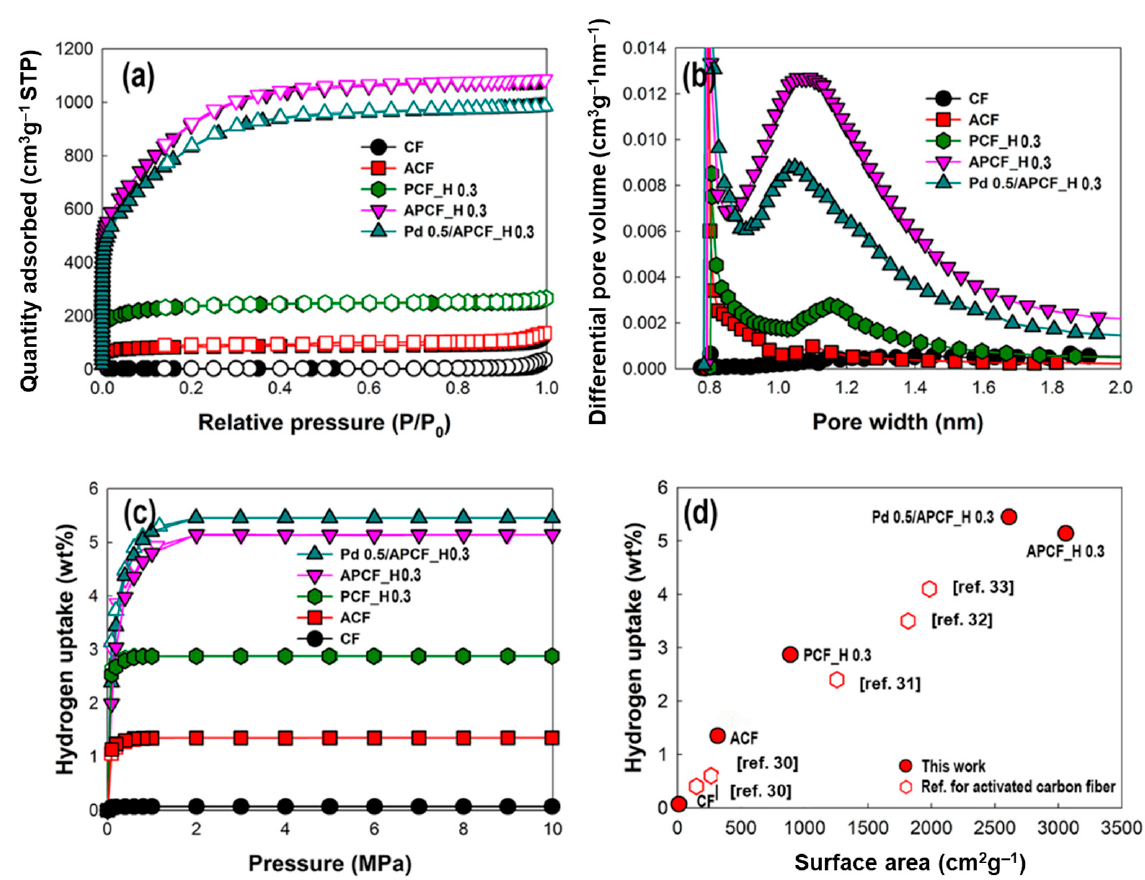
Figure 4. ( a ) N 2 adsorption–desorption isotherm (empty–filled markers); ( b ) pore size distributions and ( c ) hydrogen uptakes of CF, ACF, PCF_H 0.3, APCF_H 0.3, and Pd 0.5/APCF_H 0.3 (PdCl 2 solution concentration: 0.5 mM); ( d ) Comparison of hydrogen uptake capacity (measured at 77 K and 10 MPa) vs. surface area of activated carbon fiber (empty hexagons), as reported in the literature, and as determined in the present study (filled red circles).